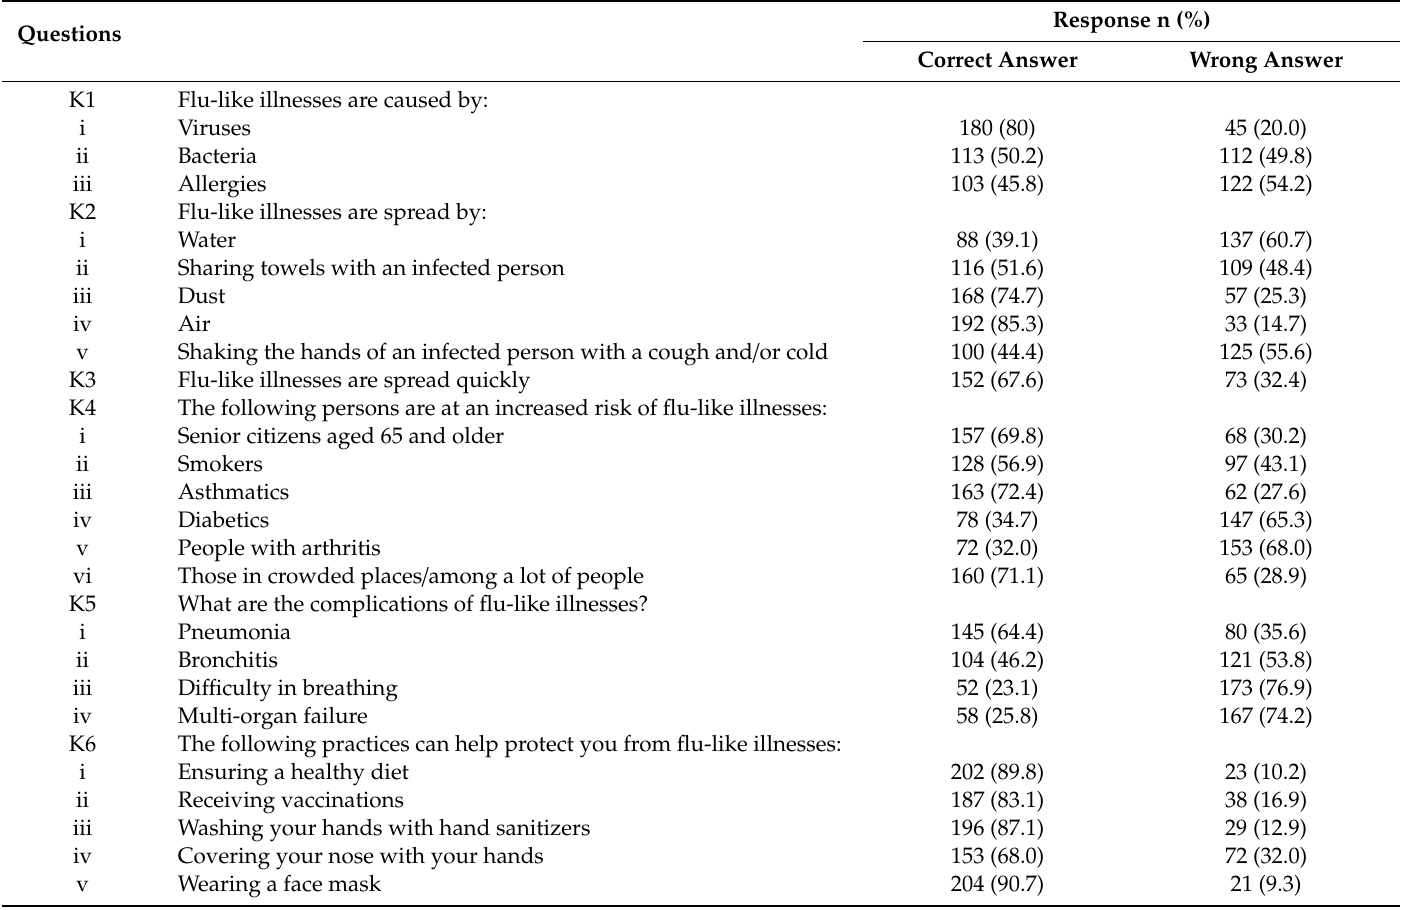
Table 2. Responses to knowledge